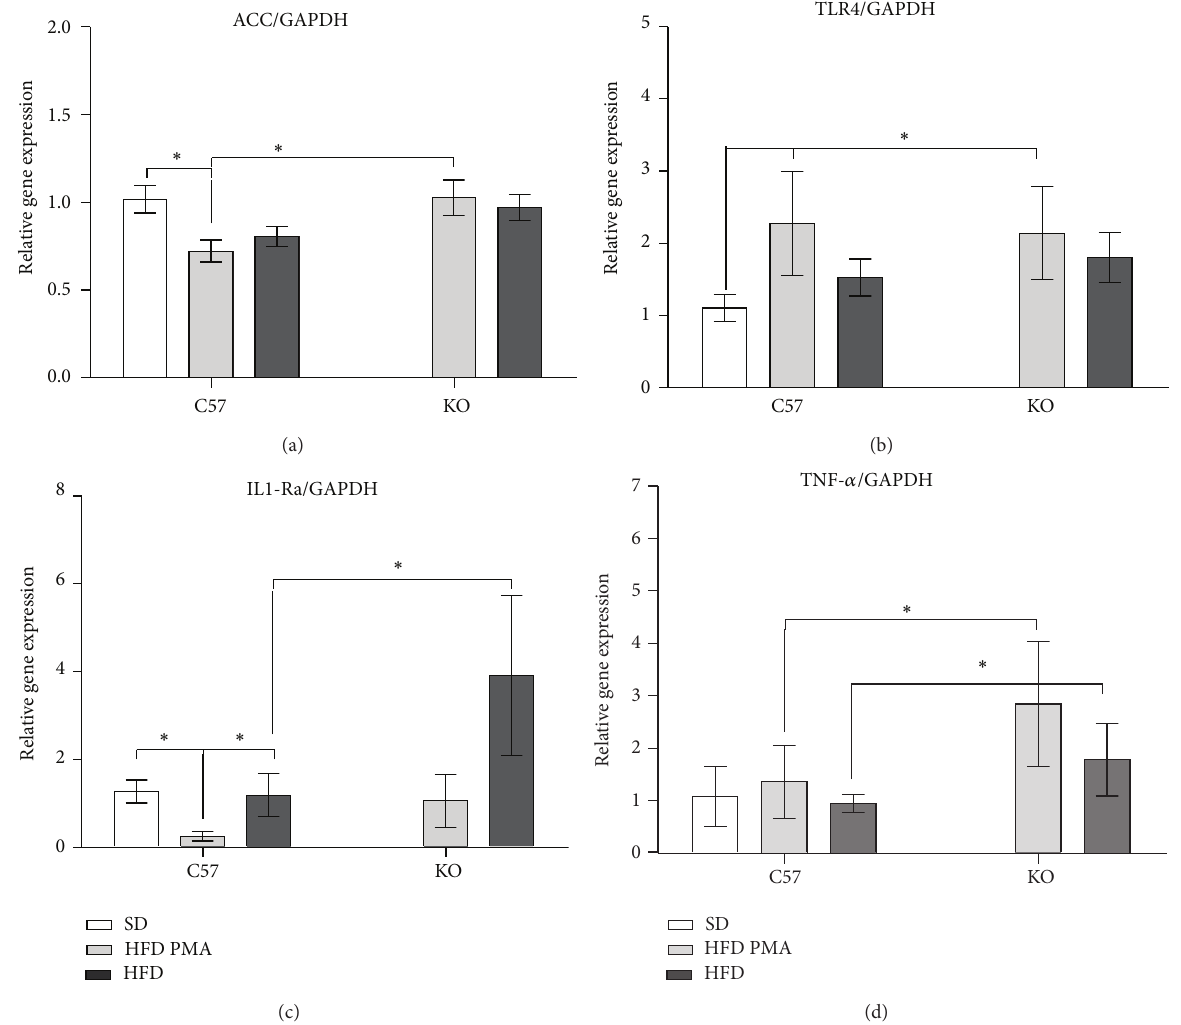
Figure 6: mRNA expression of acetyl-CoA carboxylase (ACC) (a), Toll-like receptor-4 (TLR-4) (b), antagonist receptor of interleukin-1 (IL- 1Ra) (c), and tumor necrosis factor- 𝛼 (TNF- 𝛼 ) (d) in WT mice fed with standard diet (SD) or WT and PPAR 𝛼 -knockout (KO) mice fed with a high-fat diet and treated with oleic acid (HFD) or palmitoleic acid (HFD PMA). The data are presented as mean ± SEM. ∗ 𝑃 < 0.05 versus SD; # 𝑃 < 0.05 HFD versus HFD PMA; and $ 𝑃 < 0.05 KO versus the respective WT control (one-way ANOVA followed by Bonferroni